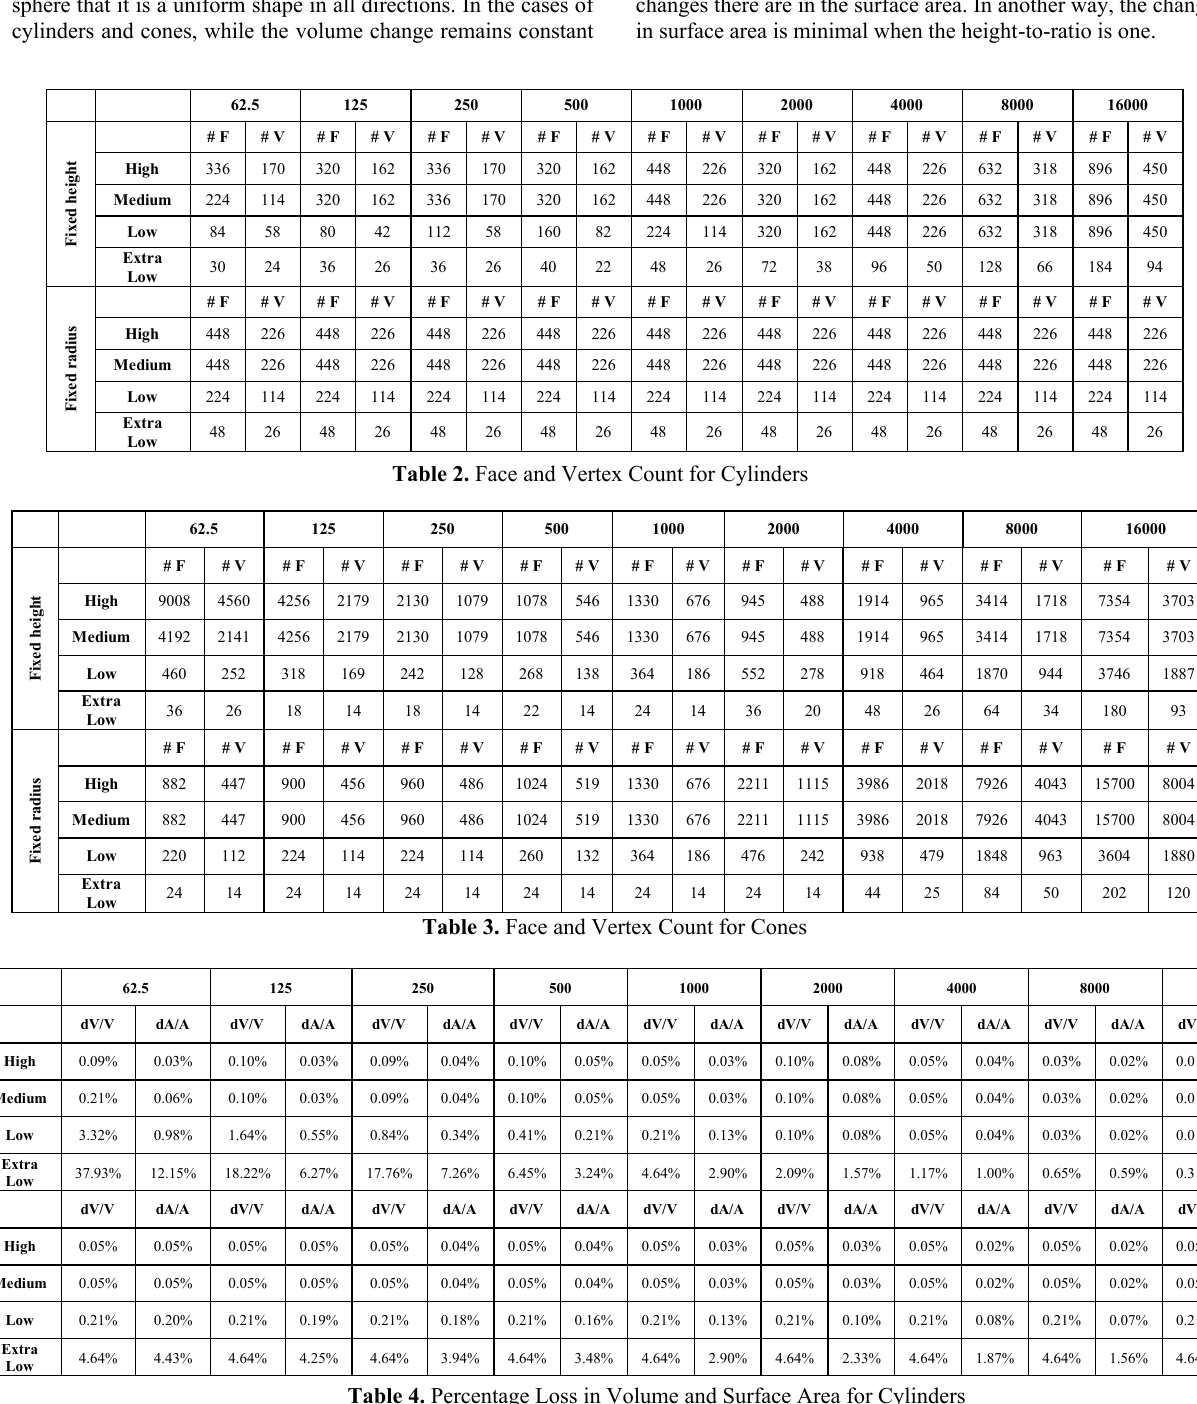
Table 4. Percentage Loss in Volume and Surface Area for